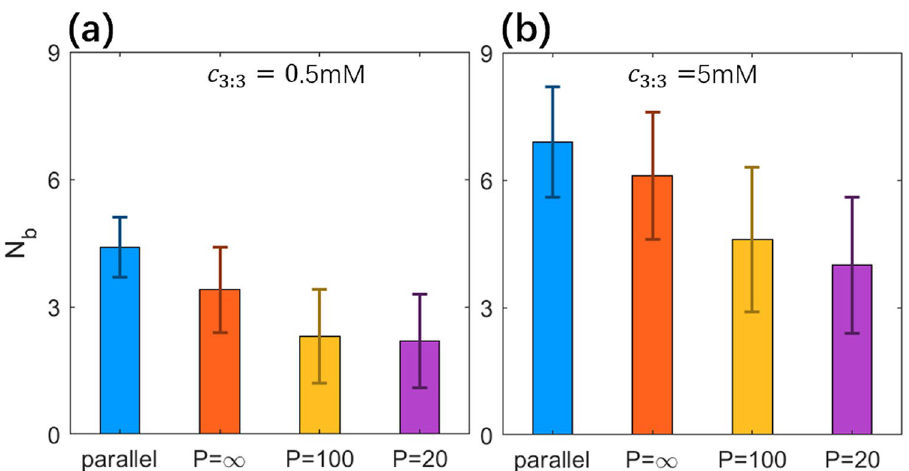
Figure 4. Number N b of bridging ions between two PEs for different salt conditions: c 3:3 = 0.5 mM ( a ), c 3:3 = 5 mM ( b ). Errorbars represent the corresponding standard deviation Δ N b . Please note that the systems were always in the presence of 20 mM 1:1 salt